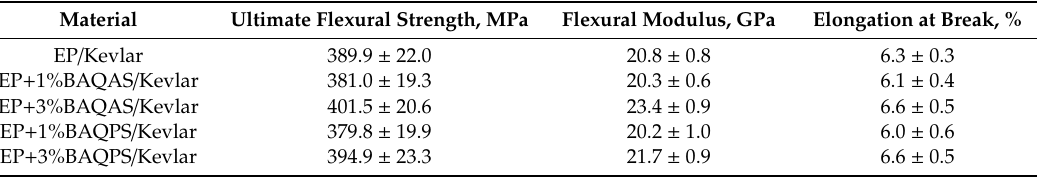
Table 2. The flexural properties of Kevlar reinforced composites 1